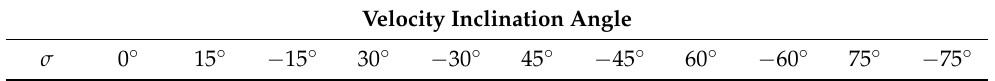
Table A3. Lateral maneuver parameters.